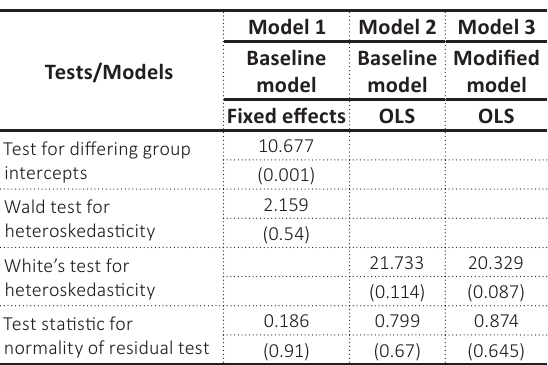
Table 5. Test for differing group